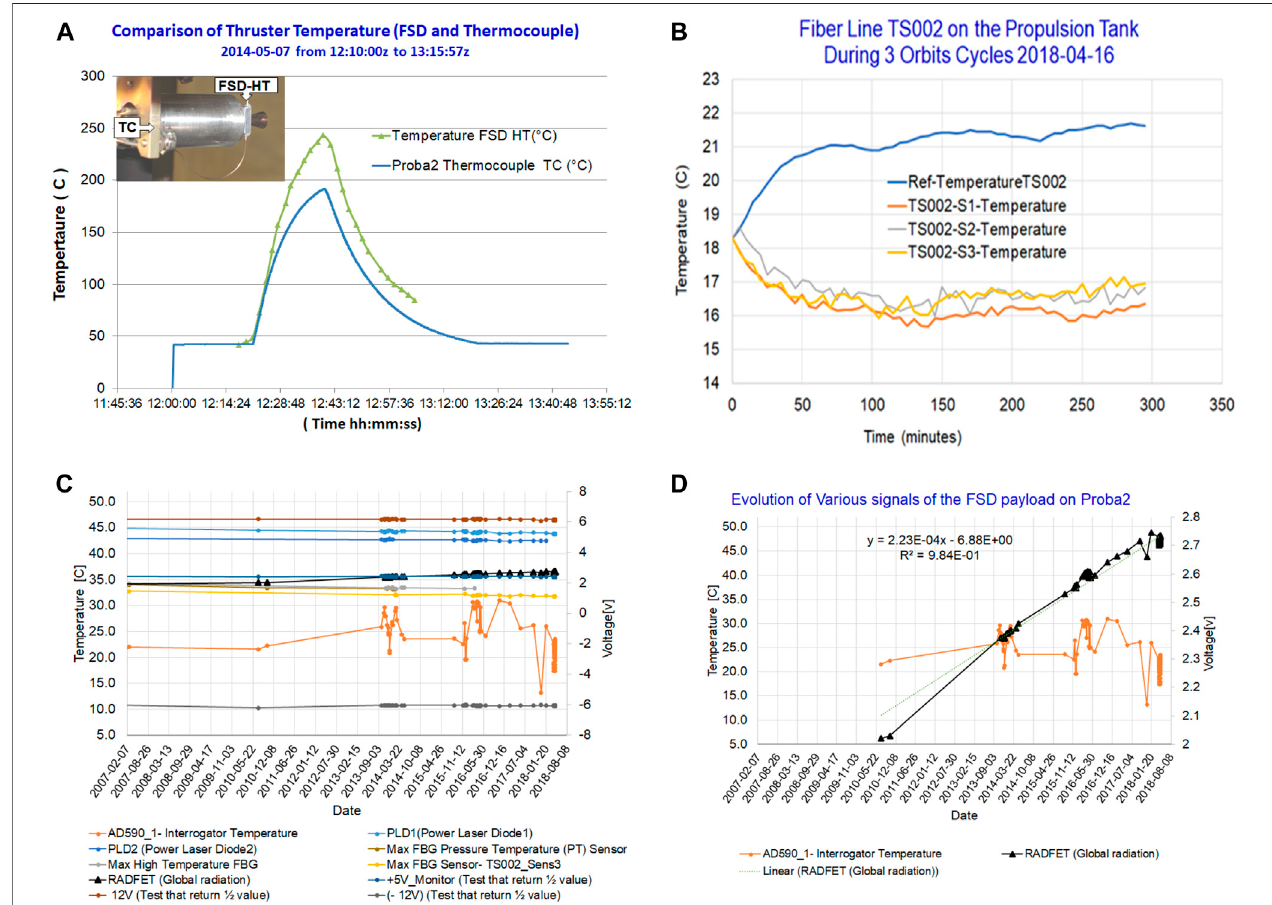
FIGURE15|(A) Measurementoftemperature onProba2Thrusterduringaheatingcycle, (B) Temperatureof3FBGsofLine2DuringThreeOrbitCycles2018-04- 16, (C) Evolution of FSD signals since Integration on Proba-2 (2007-02-09 to 2018-04-16), (D) Total Radiation 2009-11-03 to 2018-04-16 (Radfet).